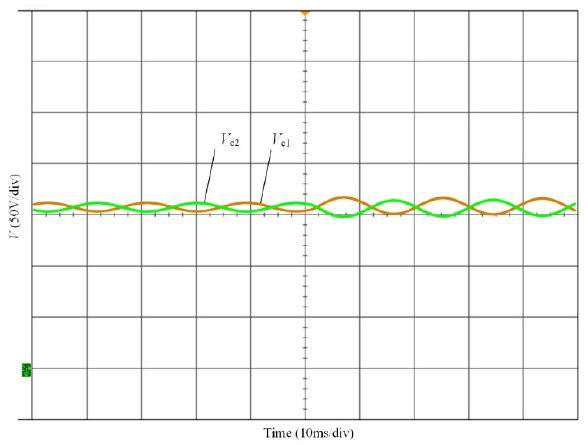
Figure 17. Curves of the capacitor voltages for the proposed MPDTC.